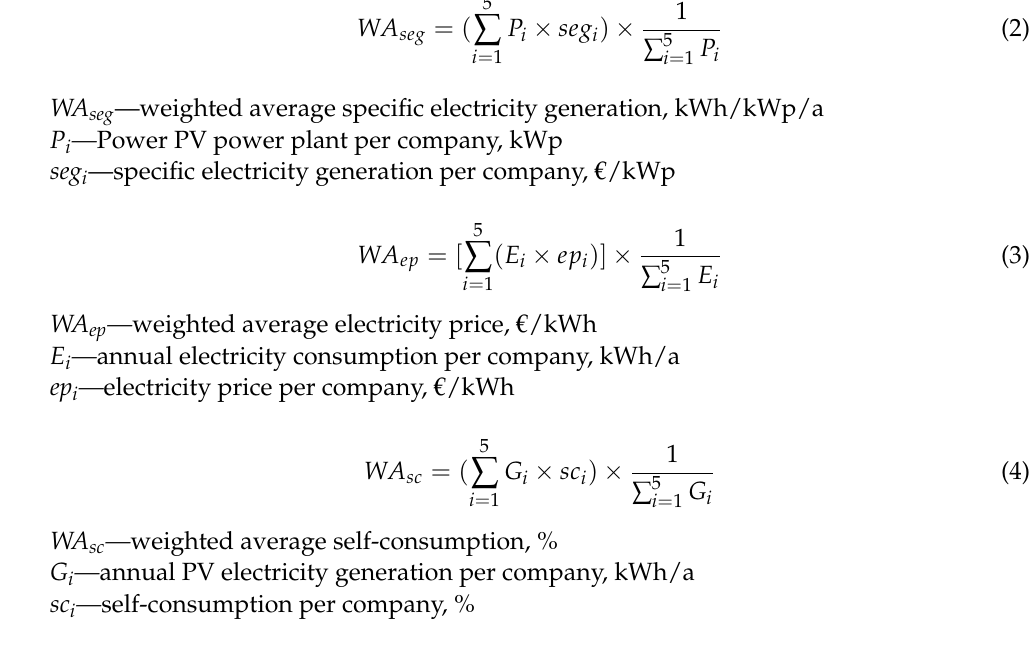
Table 3. Site-specific input data of photovoltaic citizen participation initiatives (PV-CPI). Position Sum Weighted